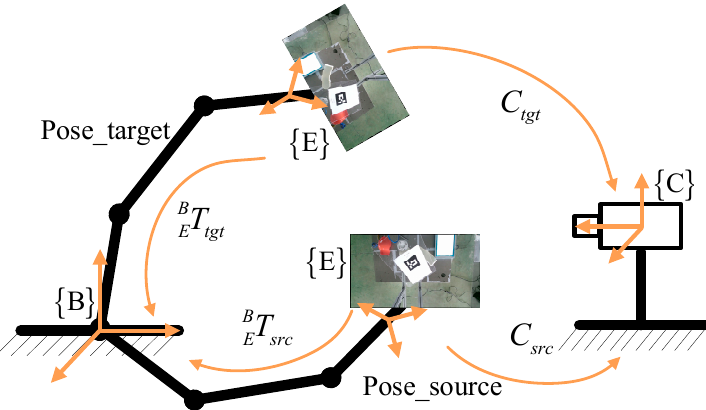
Figure 7. Hand-eye calibration diagram. The scenario in this paper belongs to the hand-eye calibration